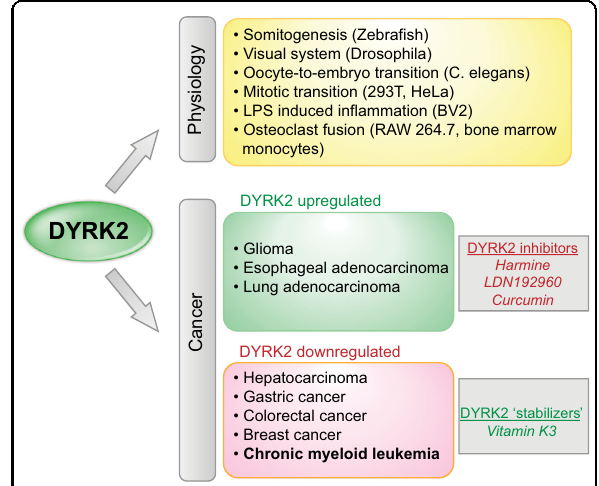
Fig. 4 Roles of DYRK2 in normal and malignant tissues. DYRK2 is involved in physiological and malignant processes. In cancer, DYRK2 is considered to play a pro-oncogenic role at high expression levels and a potentially tumor-suppressive role with downregulation. Known small molecules that either inhibit or stabilize DYRK2 are